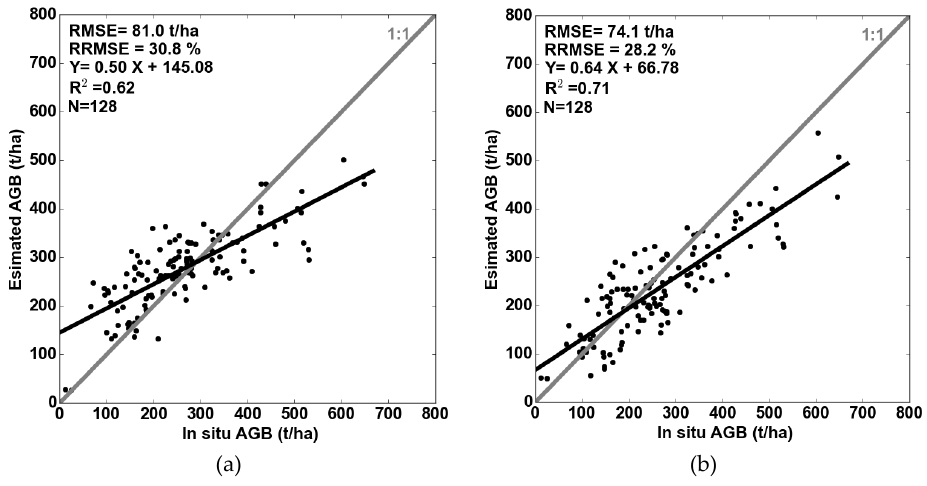
Figure 6. ( a ) Vieilledent’s AGB map as a function in situ AGB; ( b ) the improved AGB map as a function of in situ AGB. N is the number of samples used for validation.